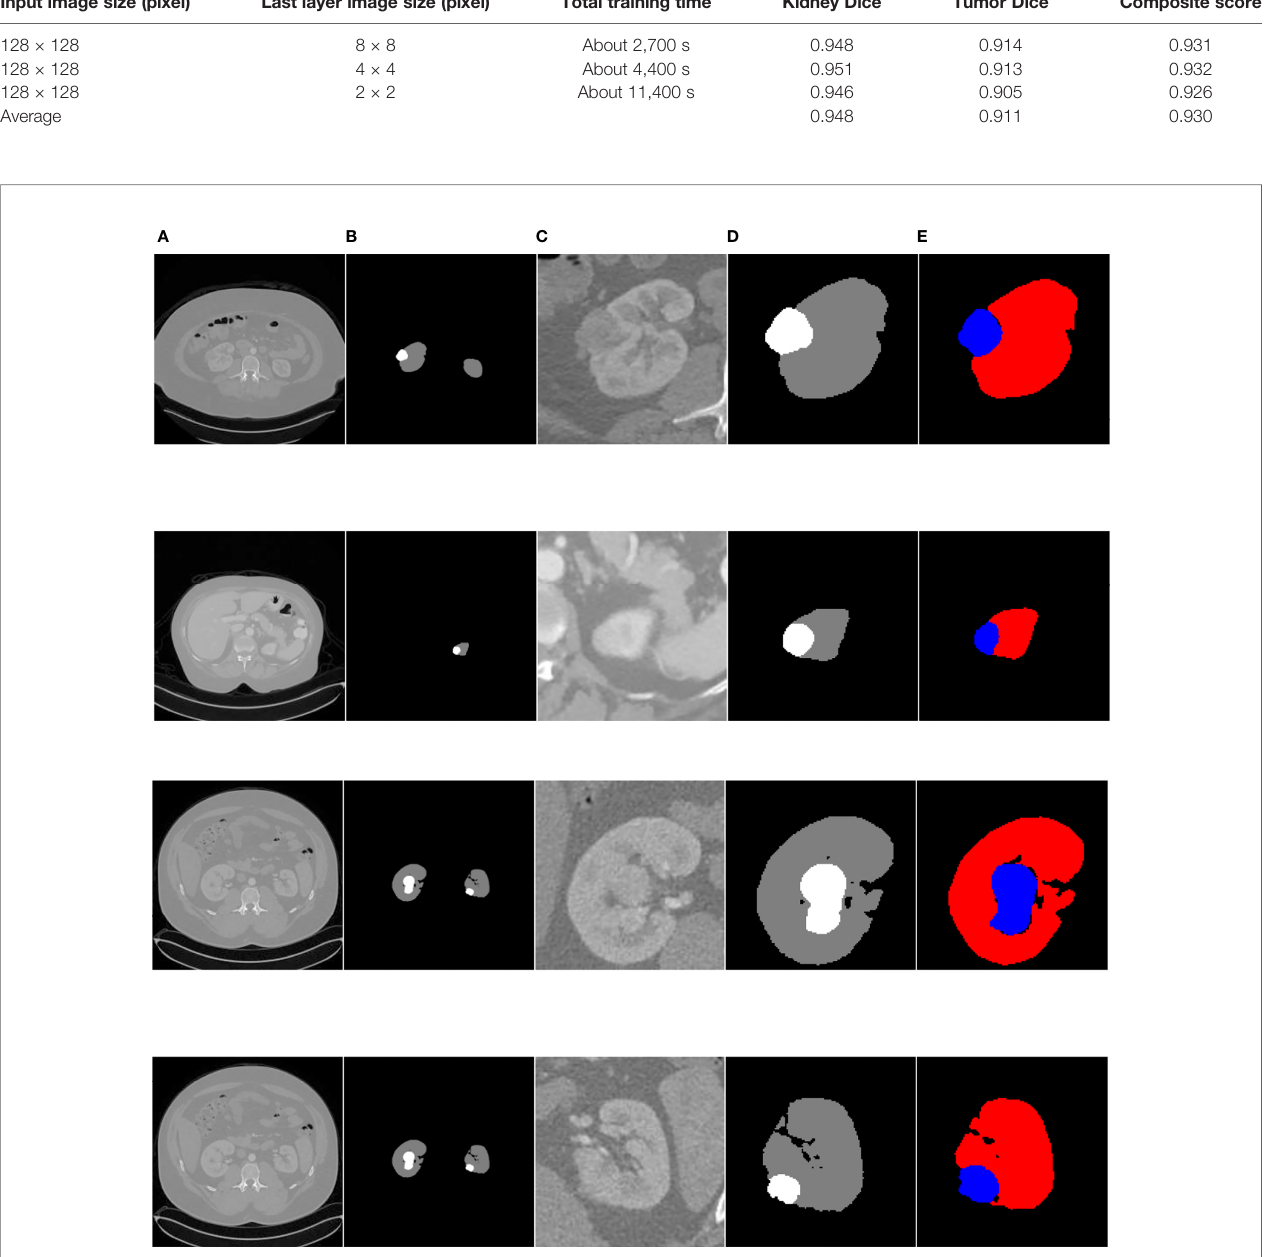
FIGURE 14 | Kidney tumor segmentation based on FR2PAttU-Net model. (A) Original image, (B) Label, (C) Result of coarse segmentation, (D) label of ROI, (E) Result of fi ne